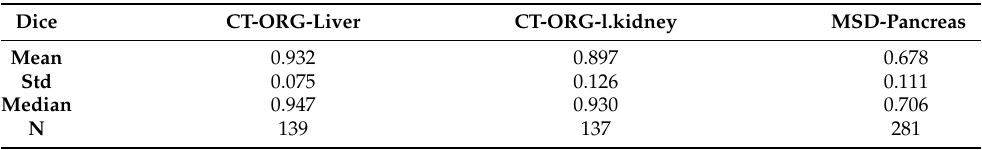
Table 2. Results of our weakly supervised segmentation models on unseen testing data. N indicates the number of test